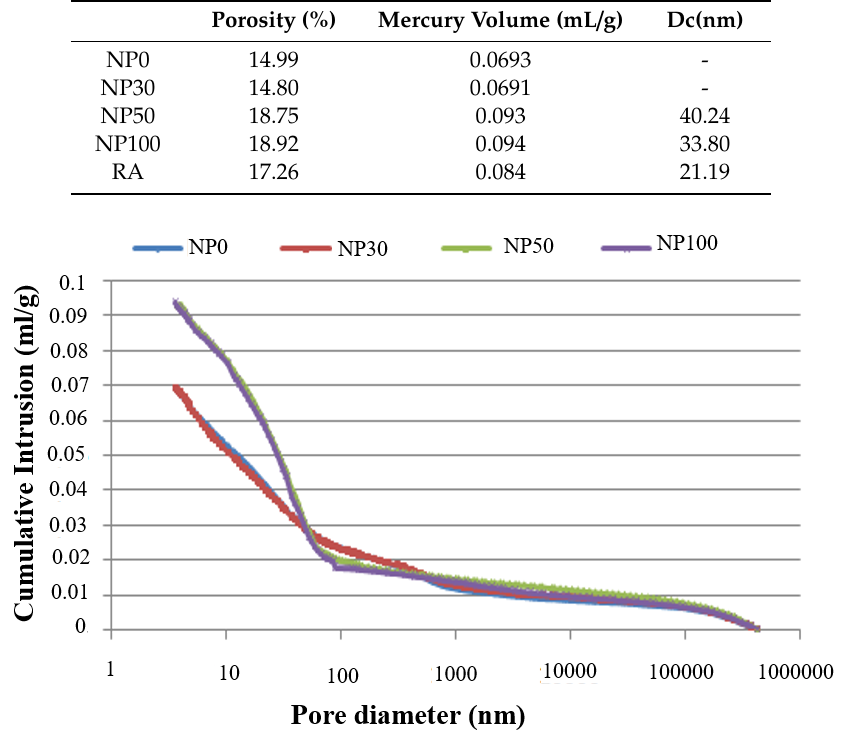
Table 4. Porosity, total intruded mercury volume and critical pore size of NP and RA.